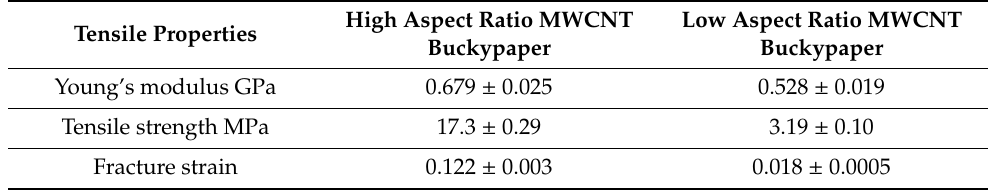
Figure 8. Stress–strain curves of buckypapers composed of high aspect ratio MWCNTs and low aspect ratio MWCNTs. Table 1. Tensile properties of buckypapers composed of high aspect ratio MWCNTs and low aspect ratio